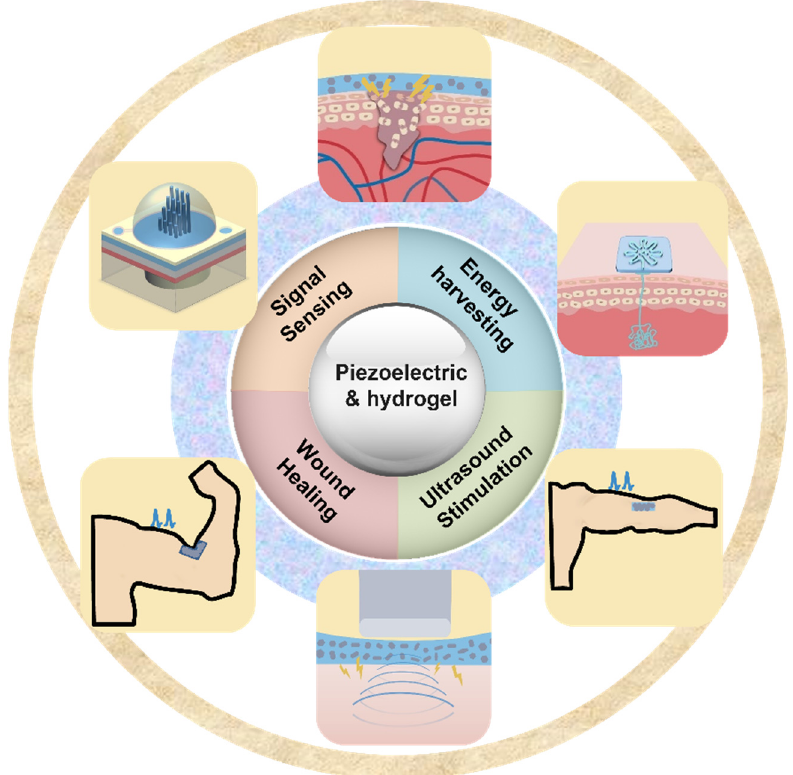
Figure 1. Overview of hydrogel-based piezoelectric devices for biomedical applications, including pressure/strain sensing, flow sensing, energy harvesting, would healing, and ultrasound stimulation/imaging.